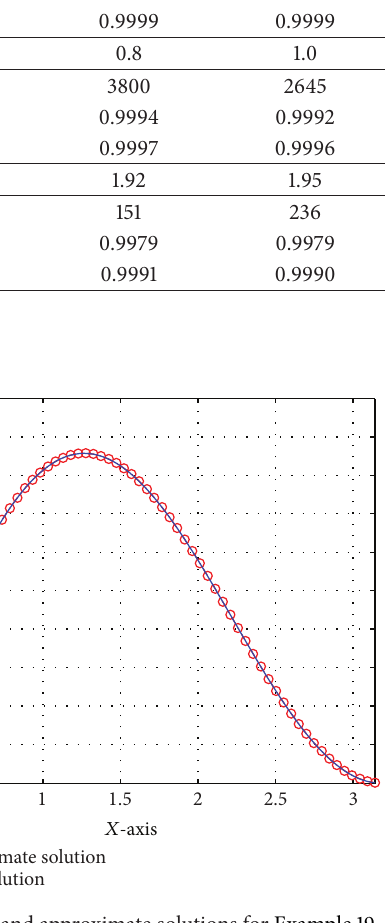
Figure 1: The exact and approximate solutions for Example 19.